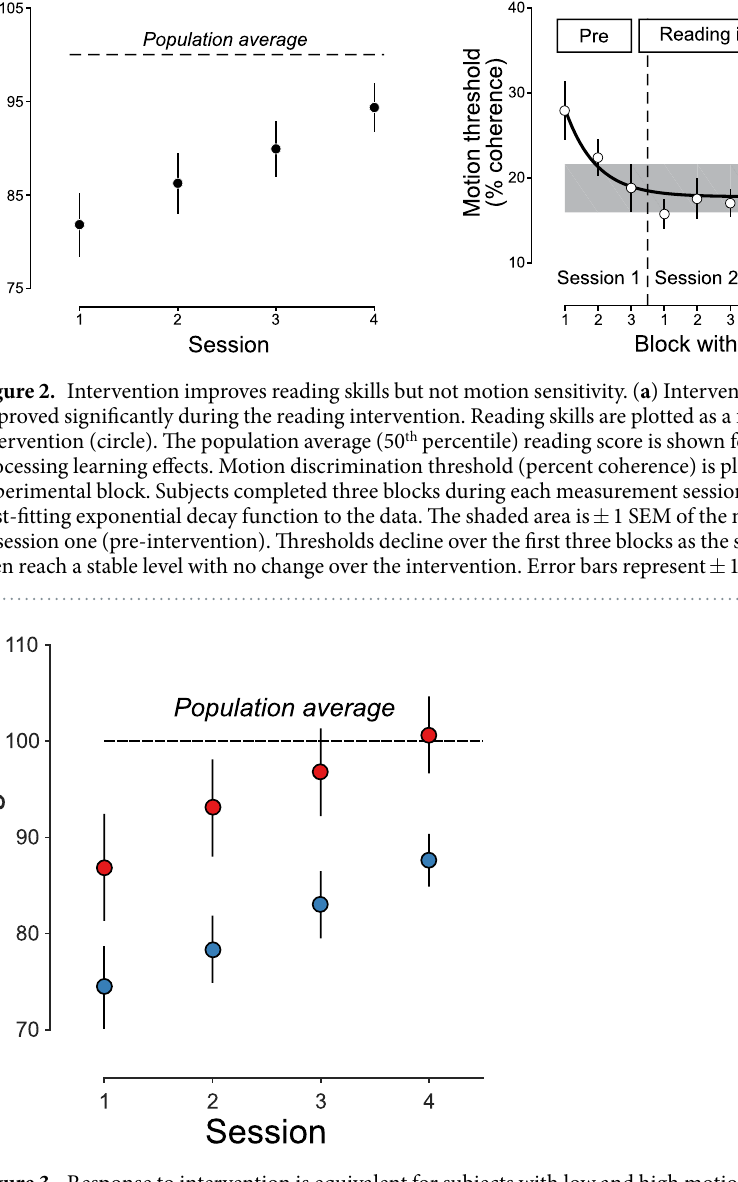
Figure 3. Response to intervention is equivalent for subjects with low and high motion sensitivity. Reading skills (y-axis) are plotted at each time point for the low motion sensitivity group (blue) and high motion sensitivity group (red). The error bars are 68% bootstrapped confidence intervals (Cis). Mean growth rate and bootstrapped 95% CI (CI 95 ) were 4.47 (CI 95 = 2.11 to 7.22) for high motion sensitivity group versus 4.40 (CI 95 = 2.44 to 6.58) for the low motion sensitivity group. Both groups showed similar improvements over the